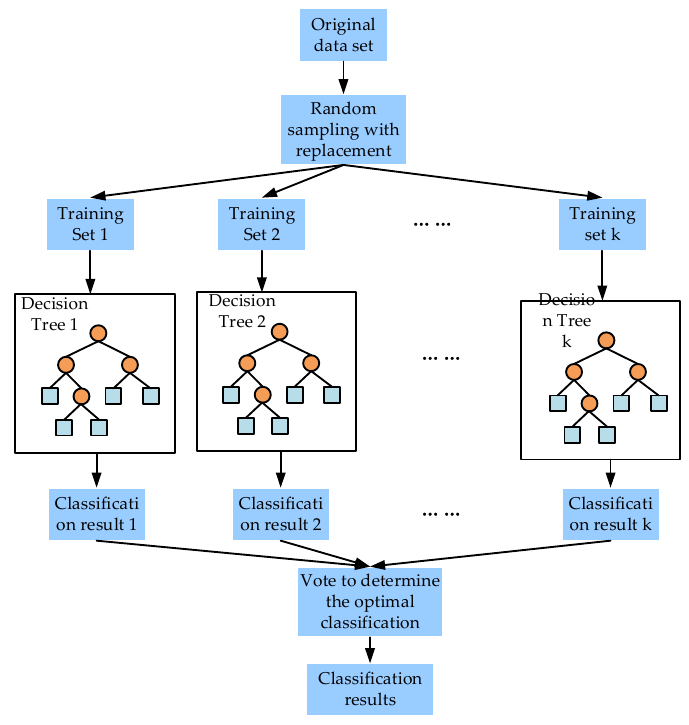
Figure 4. Random forest model diagram.